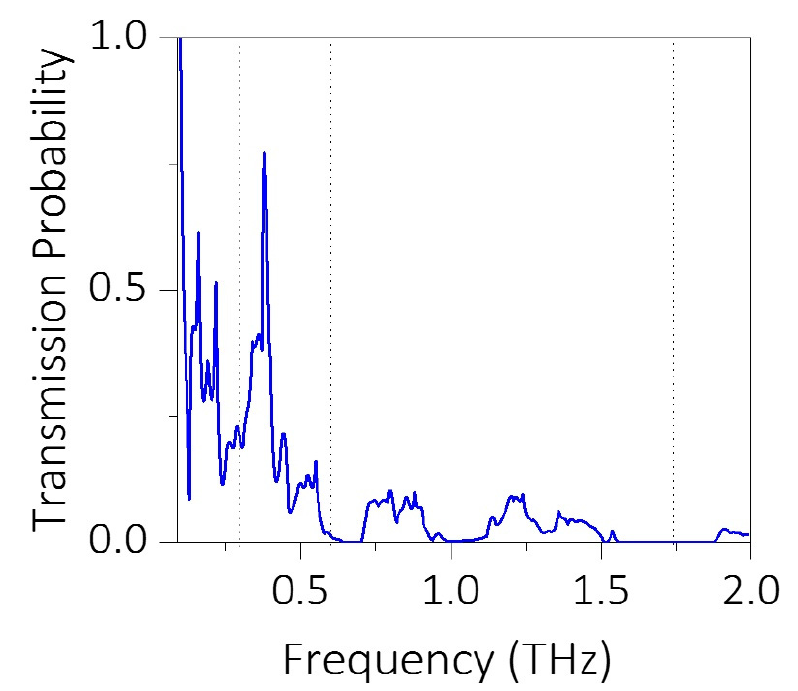
Figure 5. The transmission probability calculated as a function of phonon frequency for the snowflake shaped phononic crystal having neck length of 8 nm. The portion of the spectrum with zero transmission probability represents the phononic bandgaps in the band structure calculation.